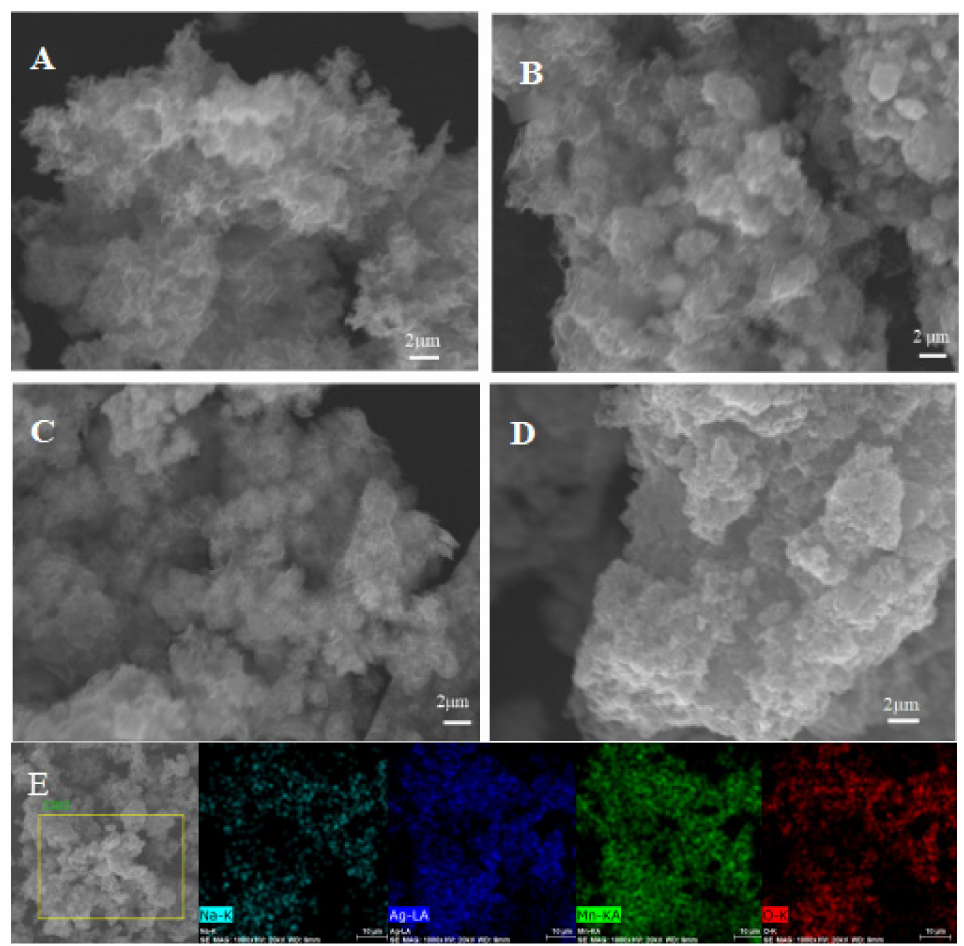
Figure 4. SEM images of ( A ) Mn-Ag-0.00, ( B ) Mn-Ag-0.05, ( C ) Mn-Ag-0.10, ( D ) Mn-Ag-0.15, and mapping of ( E )